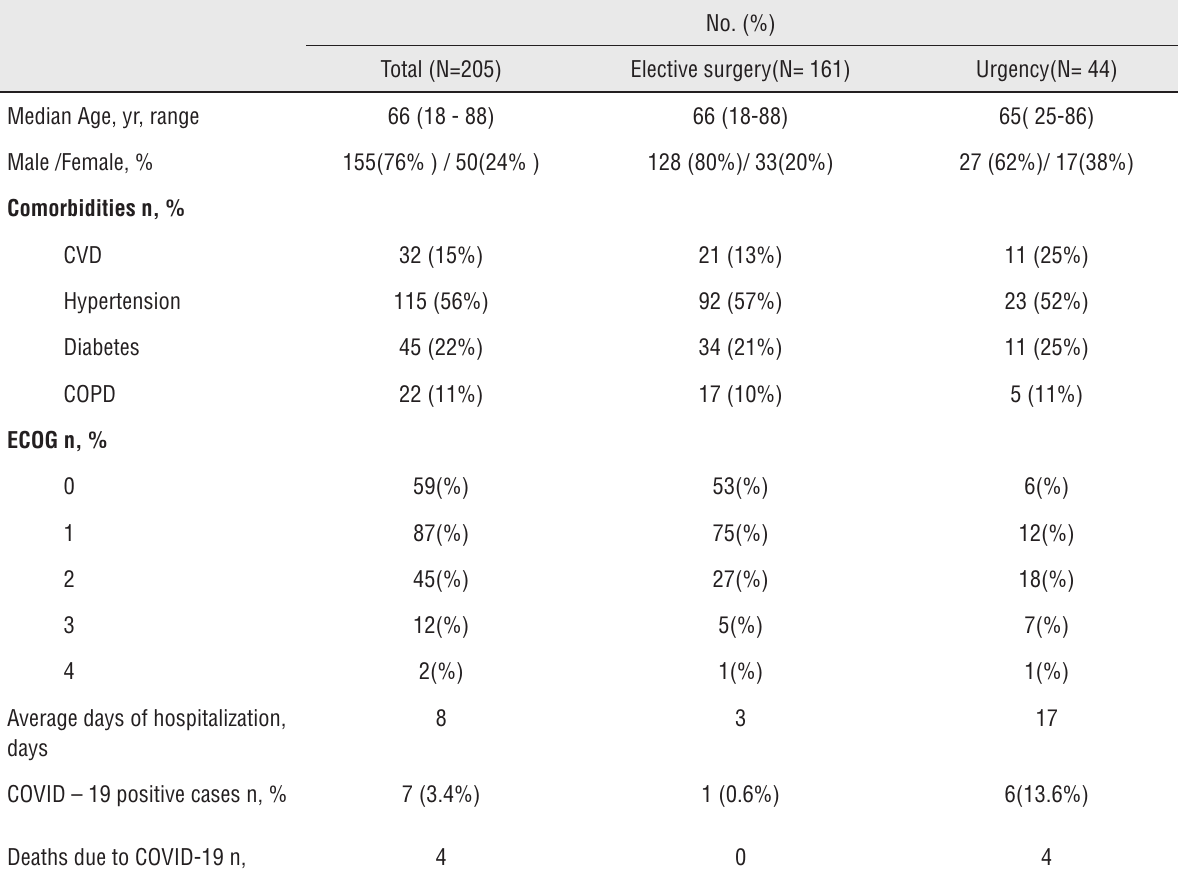
Table 1 - Baseline characteristics of operative patients at the COVID-19 pandemic